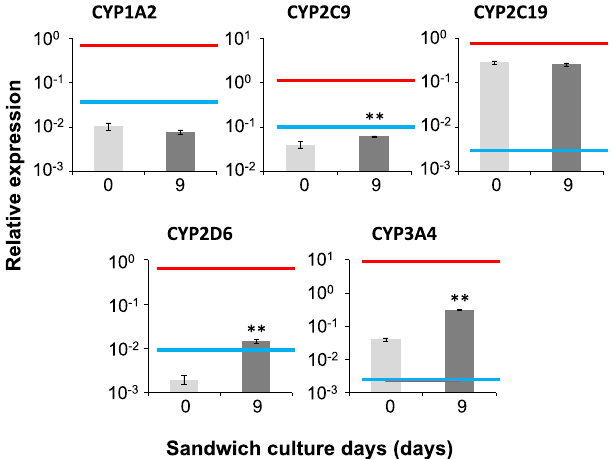
Figure 8. Gene expression of cytochrome P450 when the bile canaliculi were formed. Human-induced pluripotent stem cell-derived hepatocytes were cultured in a long-term maintenance medium for 28 days and then, they were sandwich-cultured in a maintenance medium for 9 days. The expression levels of major CYPs were measured using quantitative polymerase chain reaction before and after sandwich culture. The bar shows the relative expression levels of CYPs . Pooled RNA from human liver was used for the standard curve, and the expression level was set as one. The relative expression level was calculated using the equation of the line for the standard curve. The red line shows the maximum value of expression in 22 lots of human cryopreserved hepatocytes. The blue line shows the minimum value of expression in 22 lots of human cryopreserved hepatocytes. Data are presented as means ± SD. (n = 3). ** Shows that expression significantly increased compared with that before sandwich culture (P <